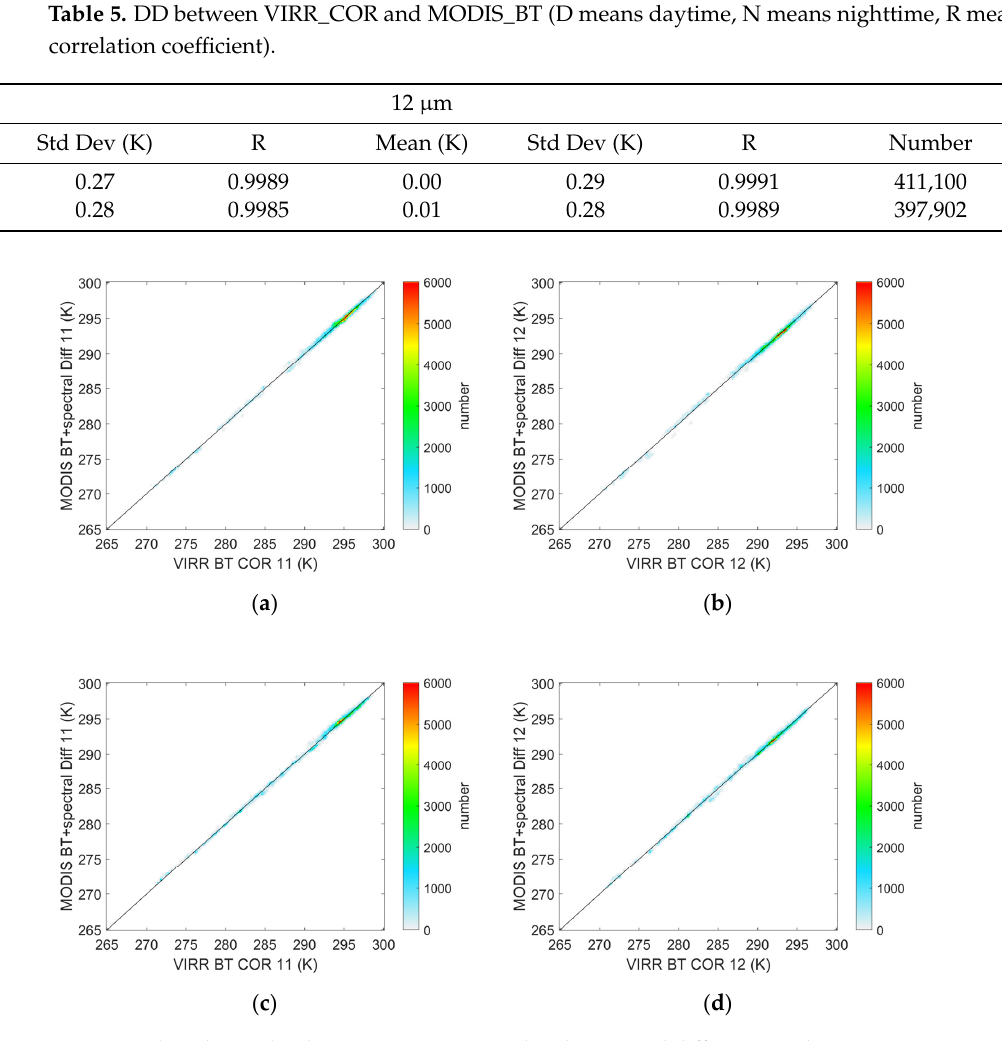
Figure 6. The relationship between MODIS_BT plus the spectral difference and VIRR_COR: ( a ) 11 μ m in the daytime; ( b ) 12 μ m in the daytime; ( c ) 11 μ m in the nighttime; ( d ) 12 μ m in the nighttime.